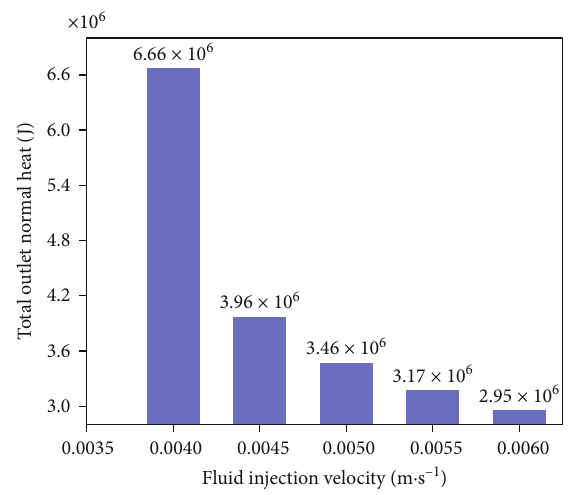
Figure 13: Comparison of total outlet normal heat at di ff erent fl uid injection